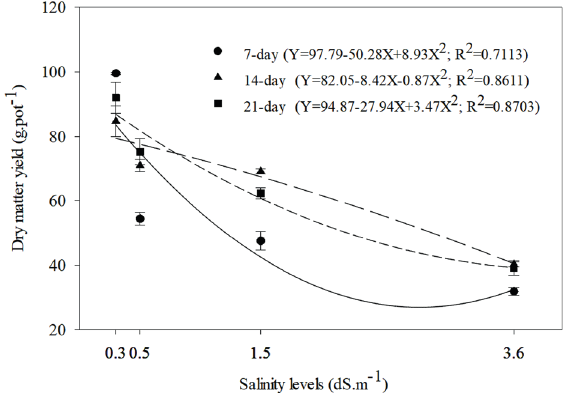
Figure 6 - Dry-matter yield of the cactus pear cv. Miúda according to the salinity levels and irrigation frequency (7-day: line solid; 14-day: line long dash and 21-day: line short dash). Error bars represent the standard error of the